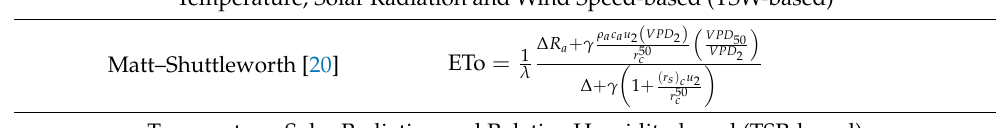
Table 2. Cont . ETo Model Equation Temperature, Solar Radiation and Wind Speed-based (TSW-based)